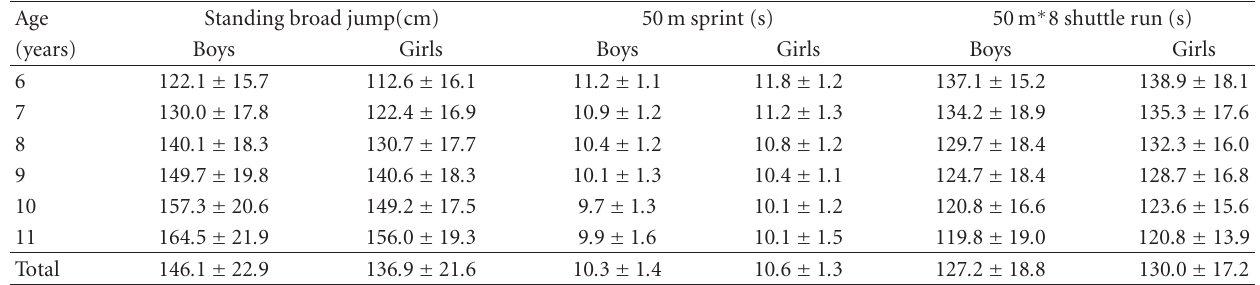
Table 2: Physical fitness test results by age and gender (Mean ± SD).